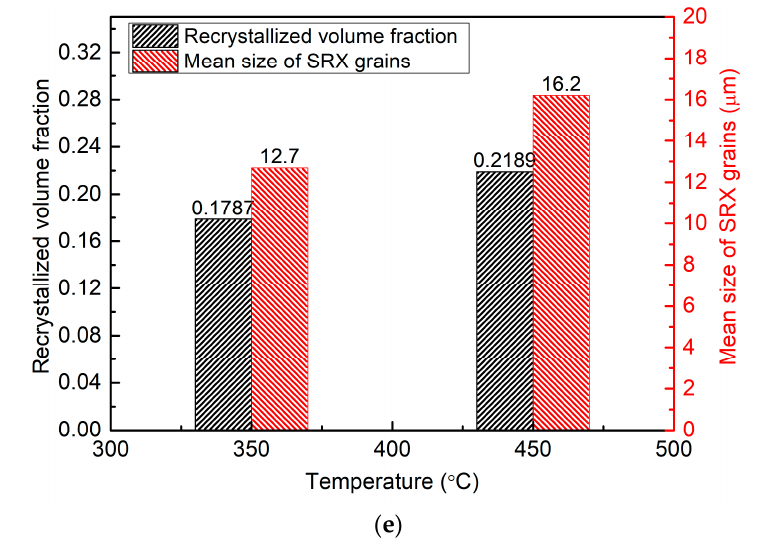
Figure 8. The experimental ( a , b ) and CA ( c , d ) results for microstructures formed at deformation temperatures of 350 ◦ C ( a , c ) and 450 ◦ C ( b , d ); ( e ) the variation of the recrystallized volume fraction and the mean grain size at temperatures of 350 ◦ C and 450 ◦ C.